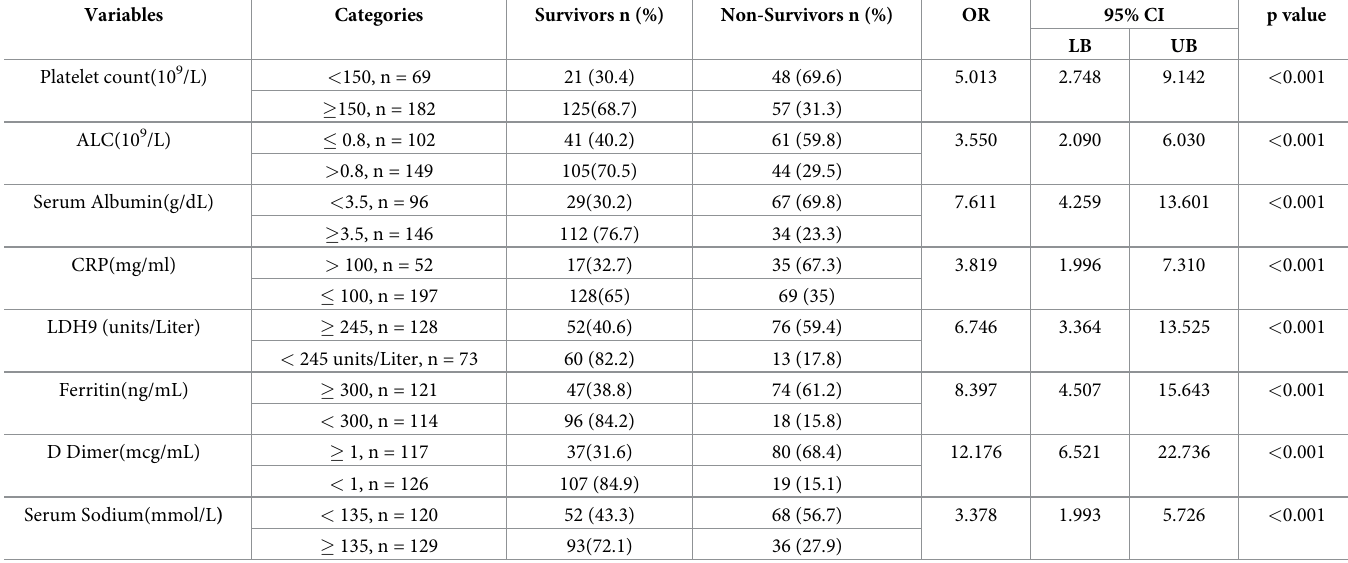
Table 2. Univariate analysis for laboratory investigations and survival.